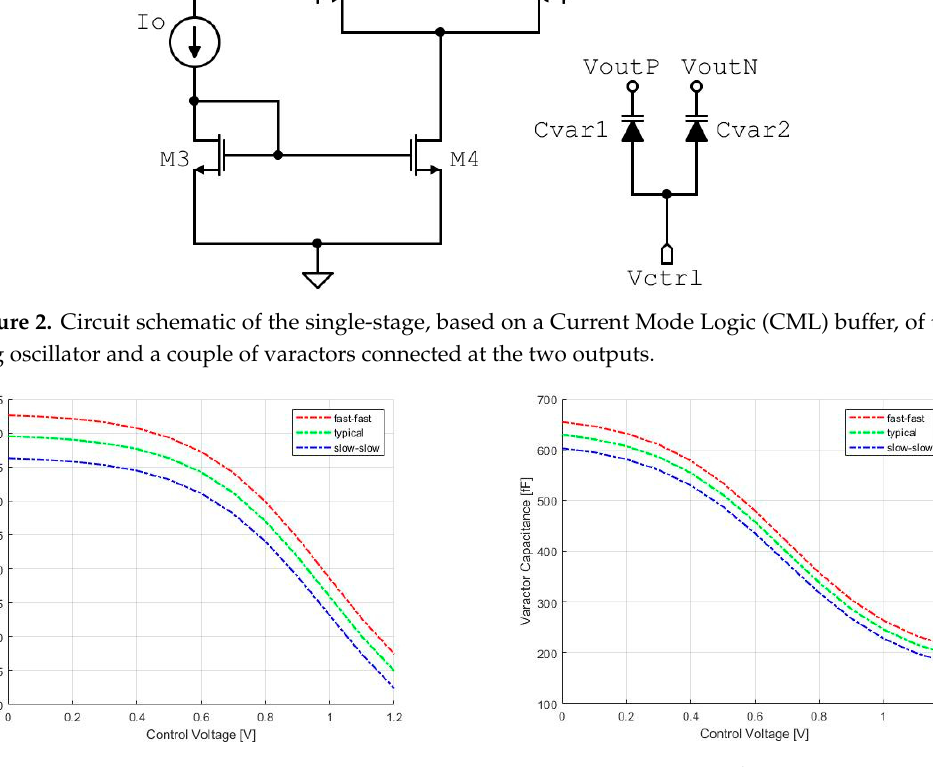
Figure 2. Circuit schematic of the single-stage, based on a Current Mode Logic (CML) buffer, of the ring oscillator and a couple of varactors connected at the two outputs.